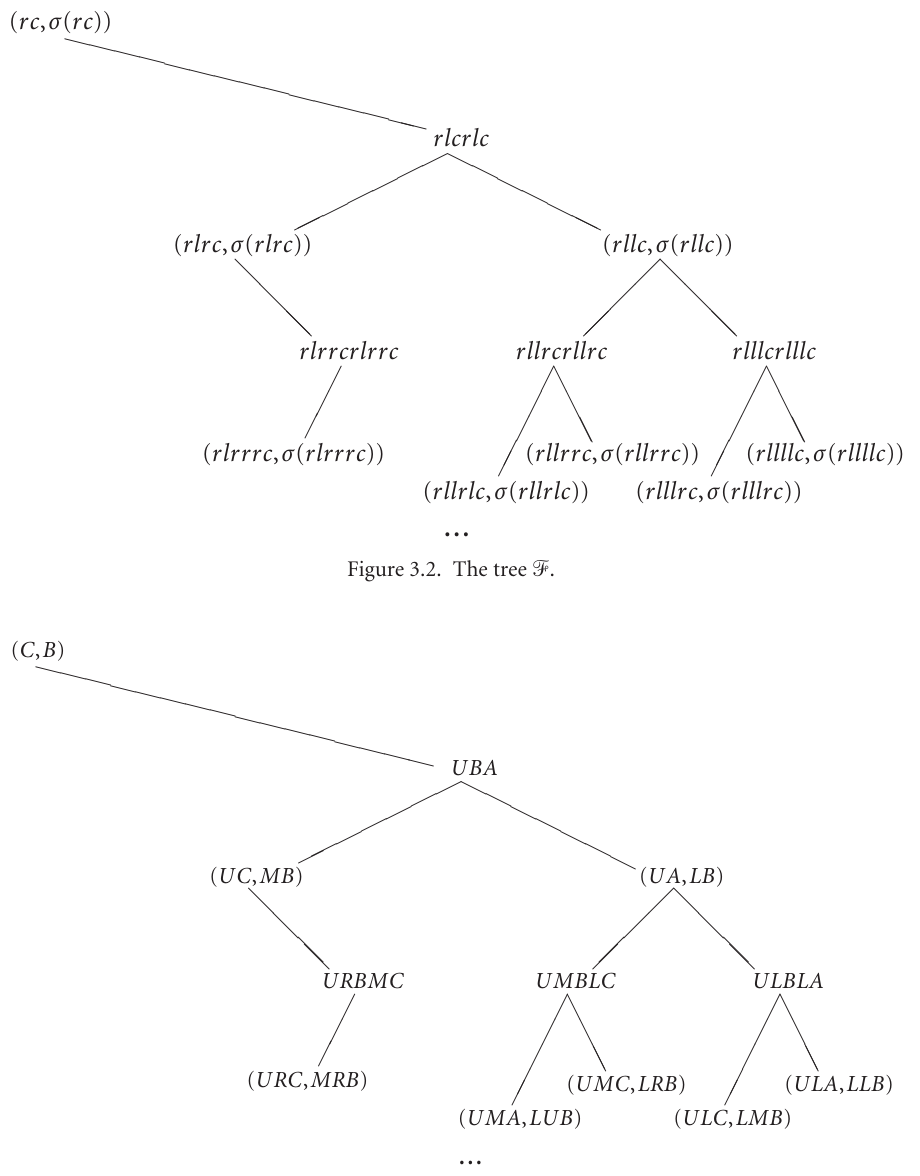
Figure 3.3. The tree (cid:7) of the second factor for the ∗